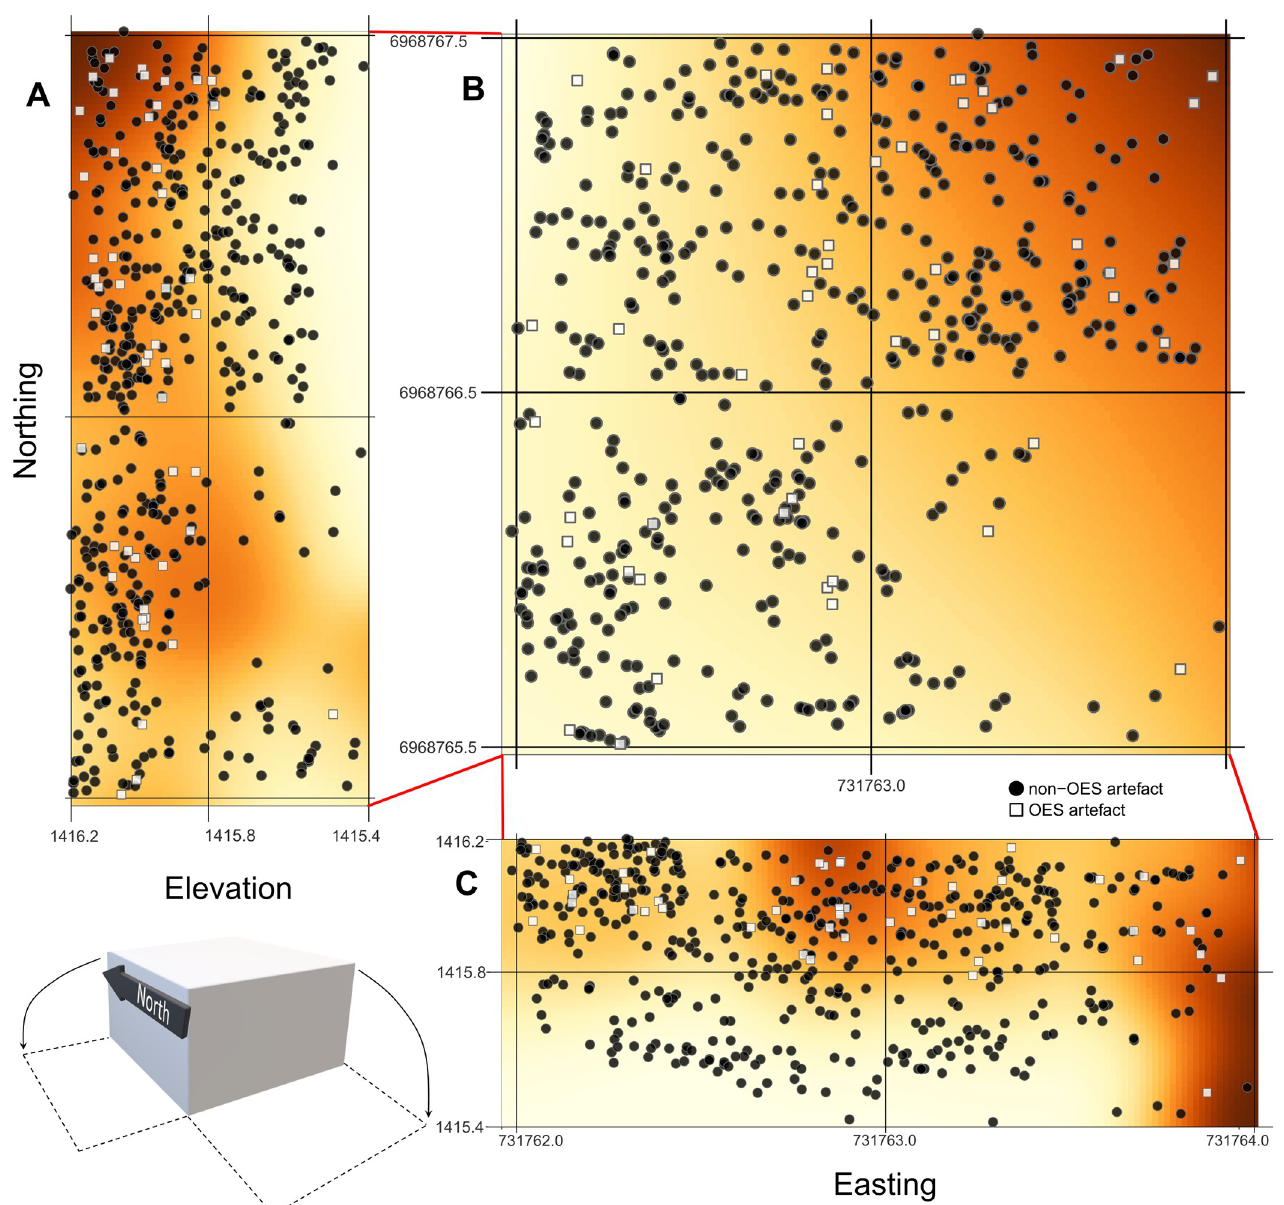
Fig 3. Relative risk surface for OES artefacts (fragments and beads) compared to all other plotted artefacts in DBGS layer at GHN. Non-OES artefacts are shown as black circles while OES artefacts are shown as white squares. The darker orange indicates areas where OES artefacts and other artefacts have a higher probability of co-occurring, while lighter areas are indicative of areas where OES artefacts and other artefacts are not likely to co-occur. A- lateral view of DBGS layer looking west. B- Aerial view of DBGS layer. C- lateral view of DBGS looking